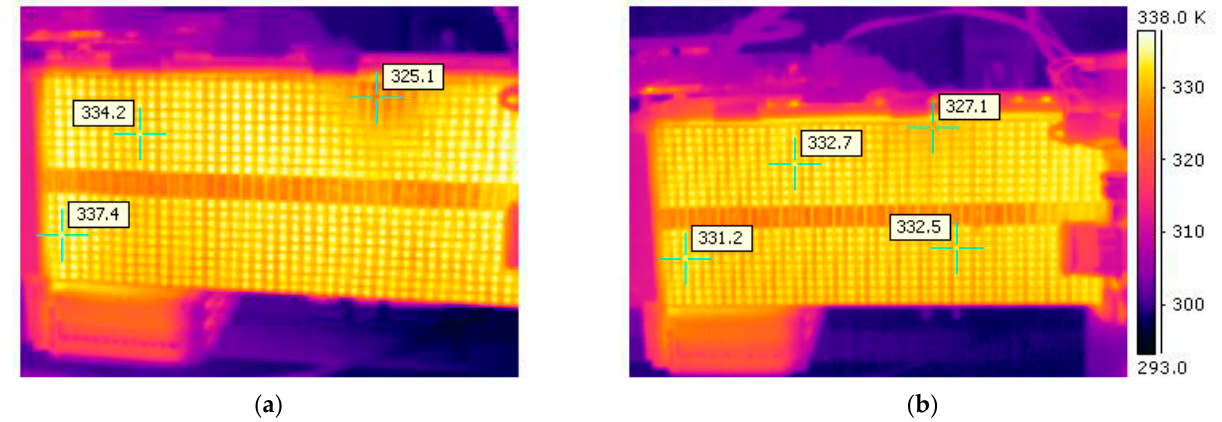
Figure 18. NEXA PEMFC stack IR-thermography at loads P = 1000 W in ( a ) original design and ( b ) modified cooling duct (Type B).